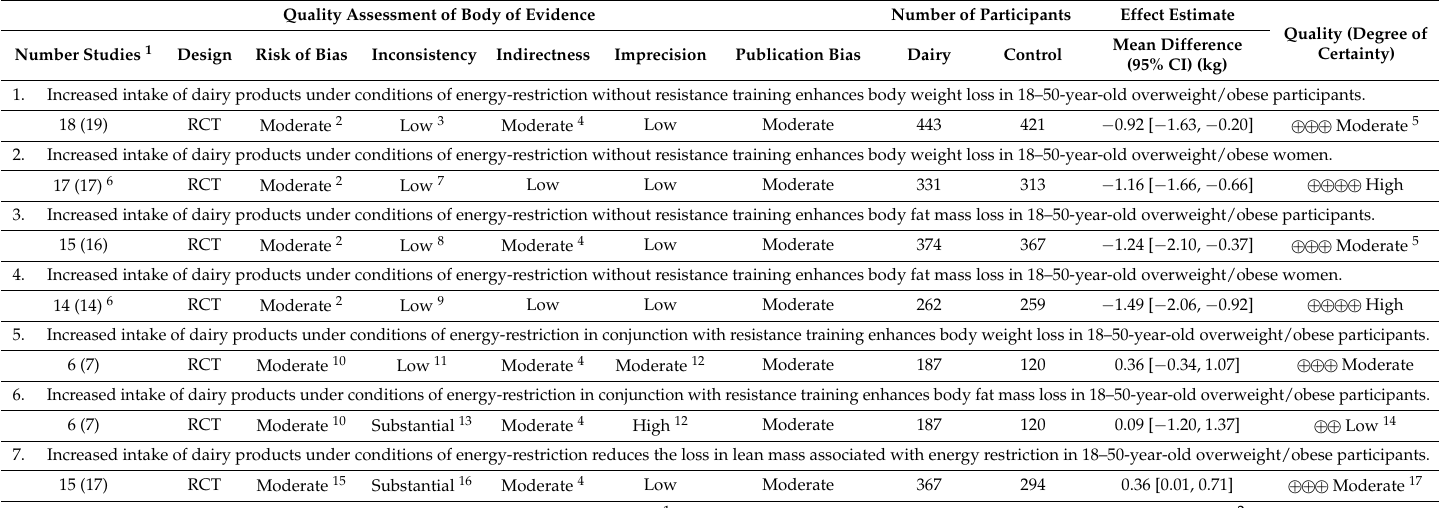
Table 2. Rating of the quality of the body of evidence using GRADE